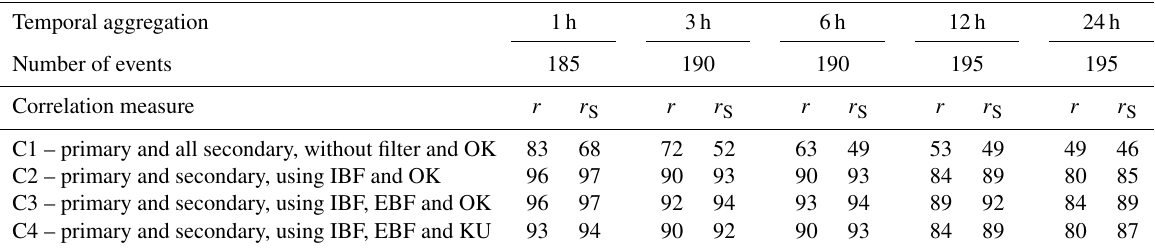
Table 4. Percentage of the stations with improved spatial correlation (compared to interpolation using primary stations only) for the config- urations C1–C4 ( r – Pearson correlation; r S – Spearman correlation). Temporal